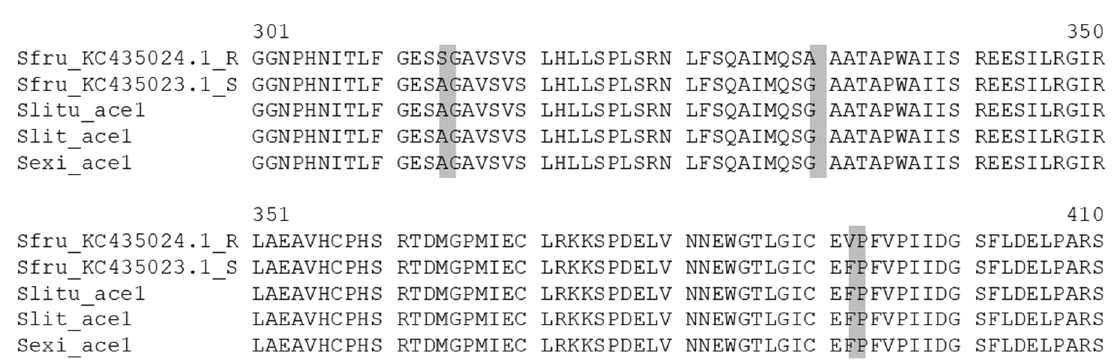
Figure 5. Alignment of a 120 amino acid sequence portion of AChE1 S. frugiperda susceptible (Genbank accession number KC435023.1) and resistant strain (KC435024.1) with orthologous sequences from S. litura (XP_022819835.1 = SlituCOE002), S. littoralis (Table S1) and S. exigua (AZB49078.1). The mutation positions are shaded in grey.